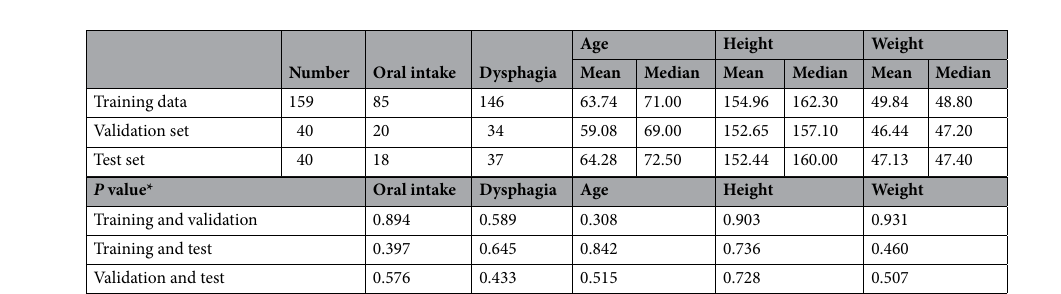
Figure 4. Workflow of the FEES-CAD.